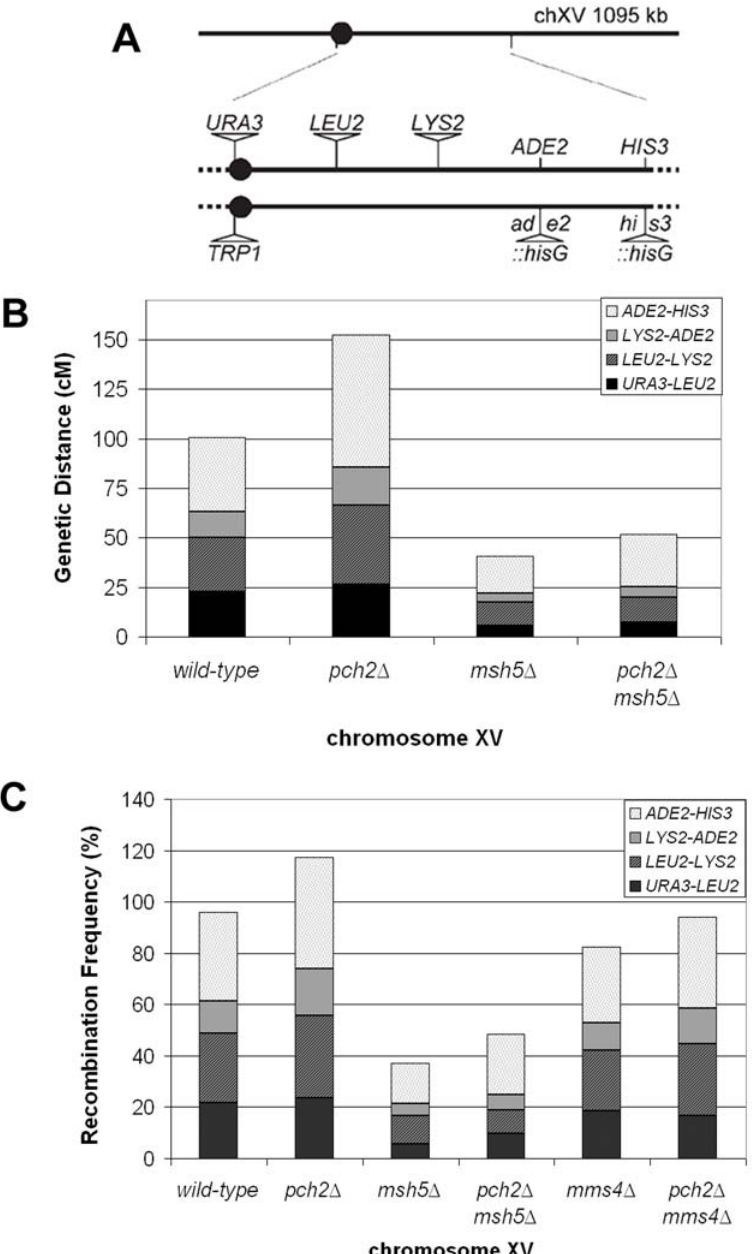
Figure 1. pch2 D has increased levels of meiotic COs on the large chromosome XV. Recombination levels in four genetic intervals were analyzed on chromosome XV in the EAY1108/EAY1112 strain background (A). CO frequencies were calculated in cM from tetrads (B) and as recombination frequencies in spores (C). See Table 1 and Table S3 for raw data and statistical analyses.